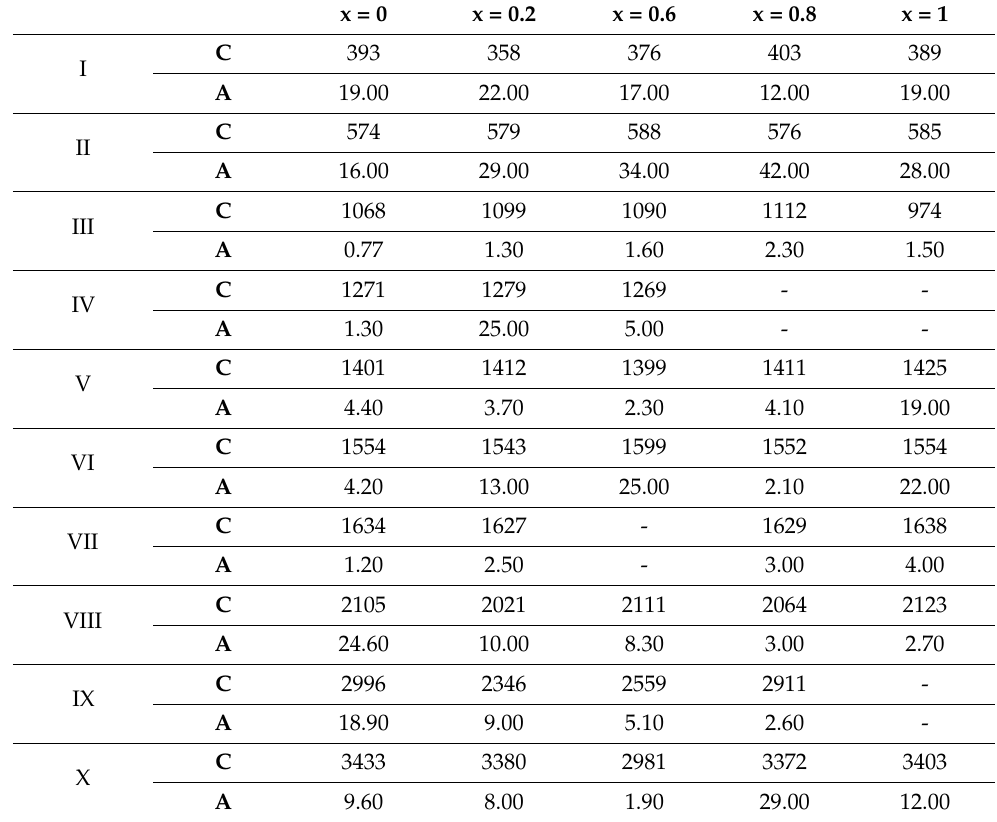
Table 5. Deconvolution parameter of the FTIR spectra of the prepared ferrites, where (C) is the component band center, and (A) denotes the relative area of the component